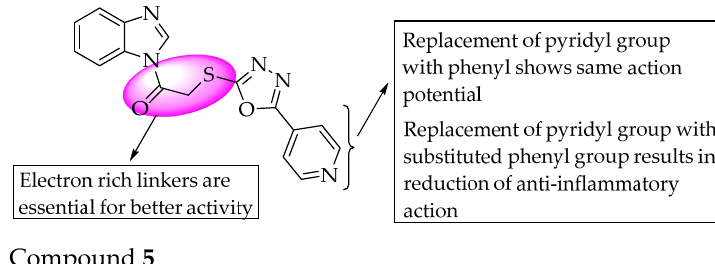
Figure 27. SARs of benzimidazole substituted with